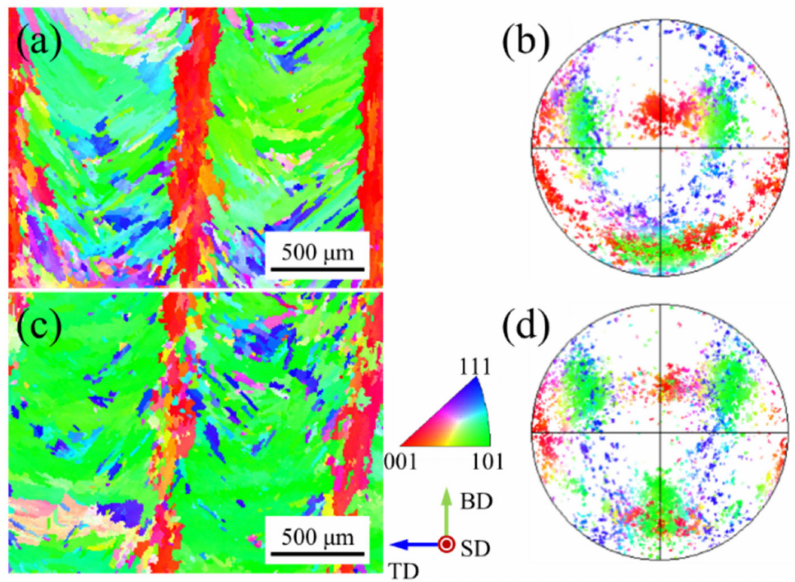
Figure 3. Inverse pole figure (IPF) maps and corresponding pole figures with different z-increment: ( a , b ) 0.2 mm; ( c , d ) 0.4